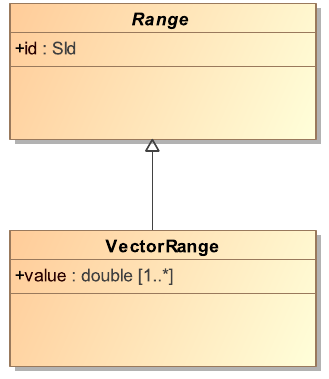
Figure 2.36: The SED-ML VectorRangeClass